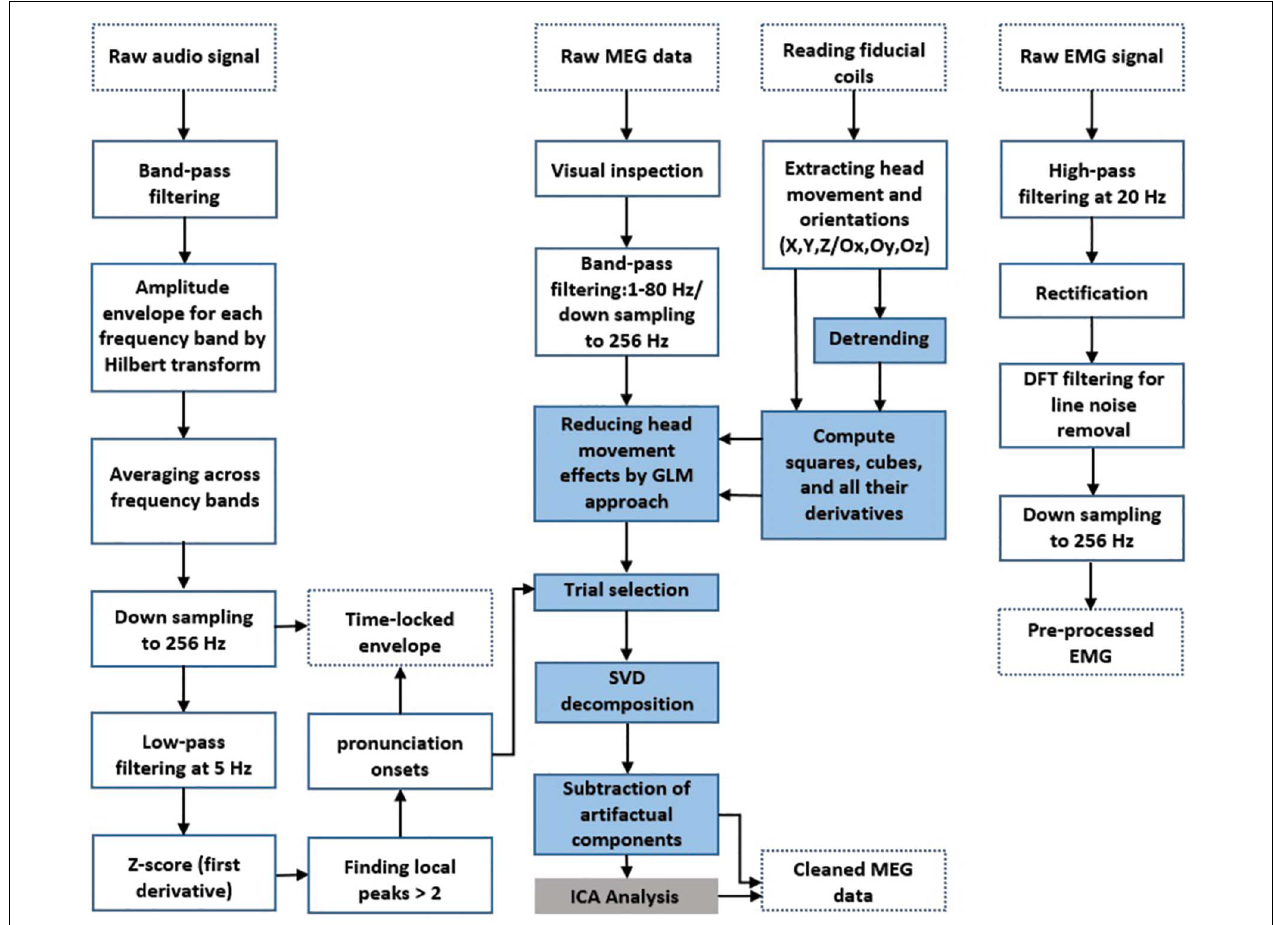
FIGURE 2 | Preprocessing and artifact rejection steps. Dotted boxes indicate data input/output. Solid line boxes indicate processing steps. Blue boxes show the main steps of MEG artifact rejection. The gray box shows a complementary step for removing residual muscle artifacts according to previous